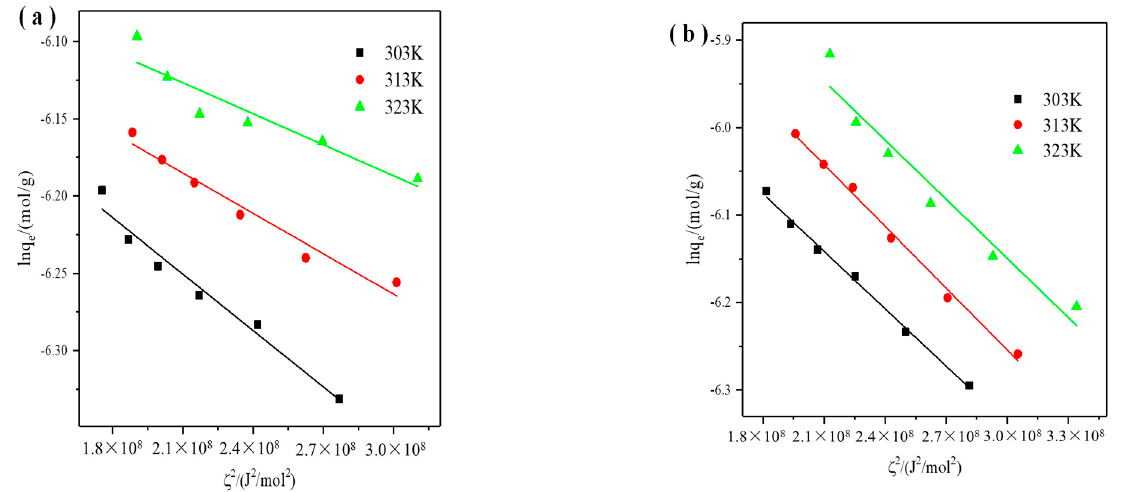
Figure 6. D-R isotherms of X zeolite for Cu 2+ ( a ) and Zn 2+ ( b ). Figure6. D-R isotherms of X zeolite for Cu 2+ ( a ) and Zn 2+ ( b ). We handled the experiments at 303 K, 313 K, and 323 K, and the results are displayed in Figure 7. It can be found that the adsorption capacities of X zeolite for Cu 2+ and Zn 2+ reached as the temperature went up, which indicated the endothermic process.